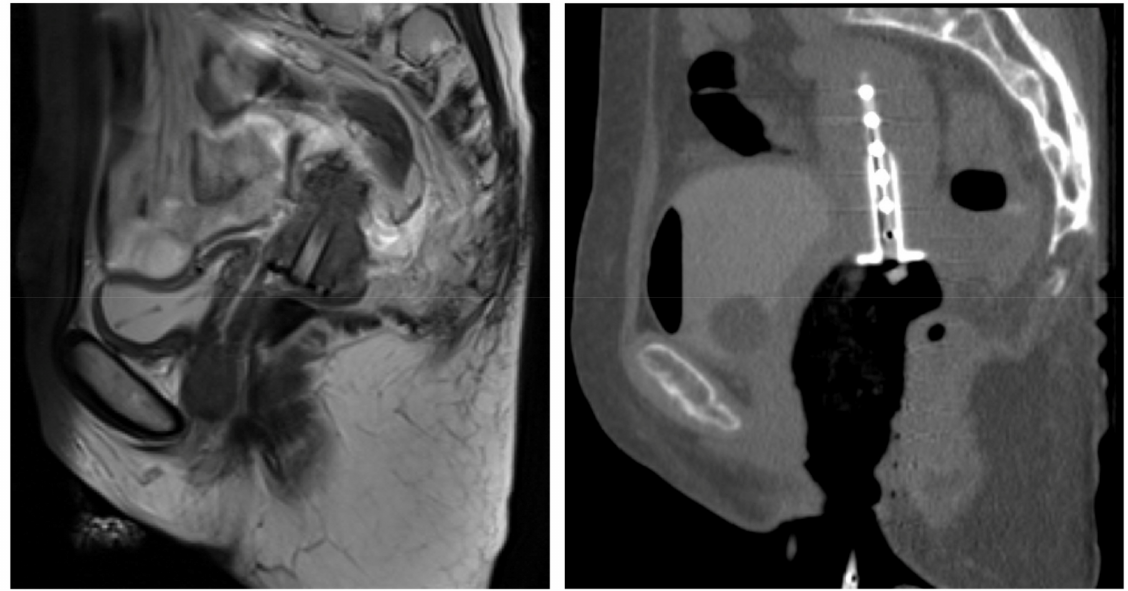
Figure 3. A uterus cranially shifted by the insertion of the vaginal